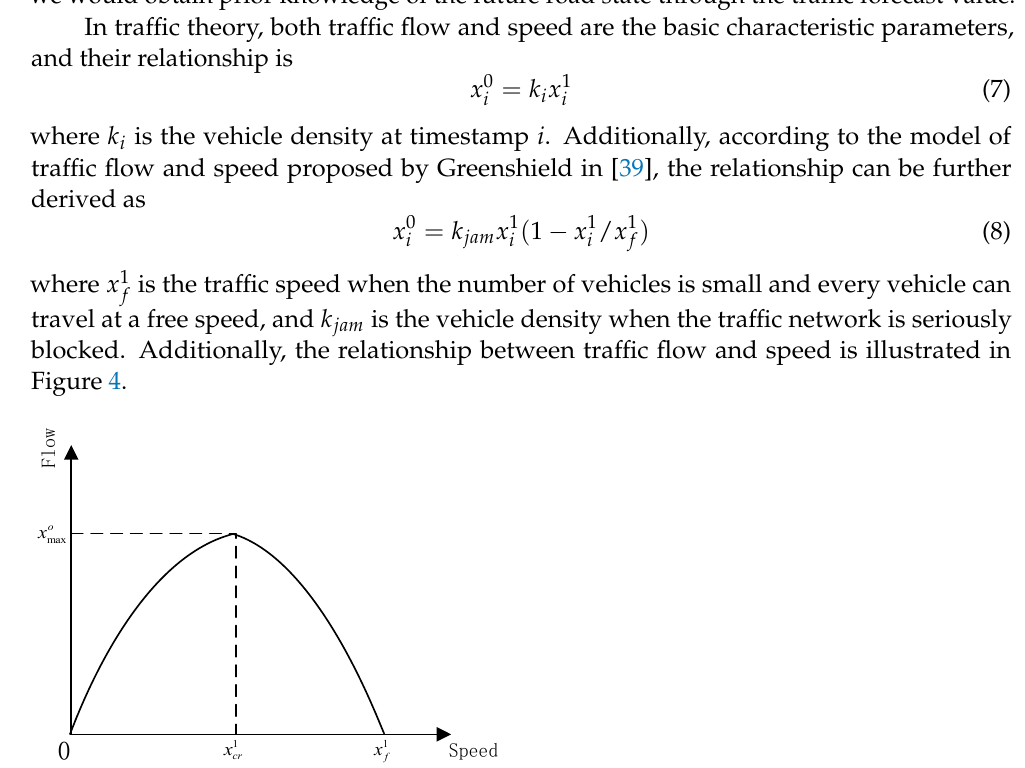
Figure 4. The relationship of traffic flow and speed.